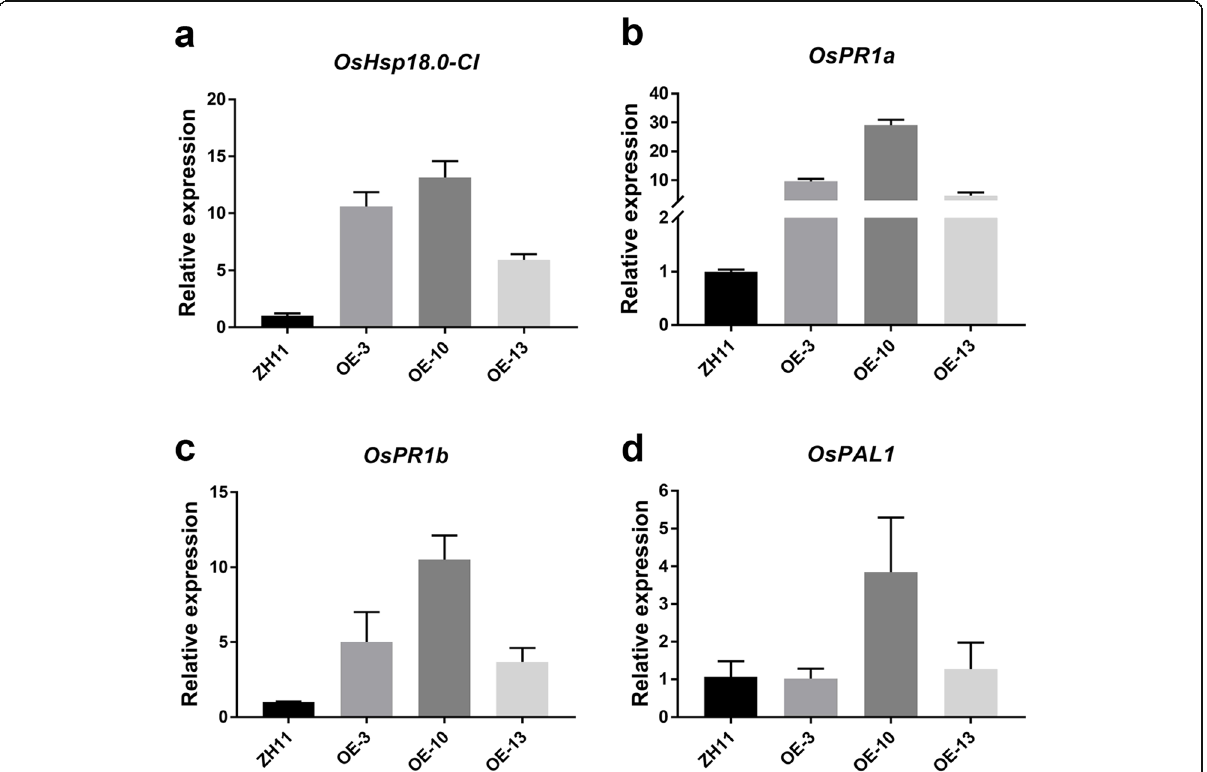
Fig. 4 Overexpressing OsHsfB4d activates the expression of OsHsp18.0-CI and pathogenesis-related genes. Quantitative RT-PCR was performed for OsHsp18.0-CI (a) and three PR genes, including OsPR1a (b) , OsPR1b (c) and OsPAL1 (d) , in 6-week-old wild-type and OsHsfB4d overexpression lines. The data are shown as the mean ± SD of three biological replicates. The experiments were repeated two times with similar